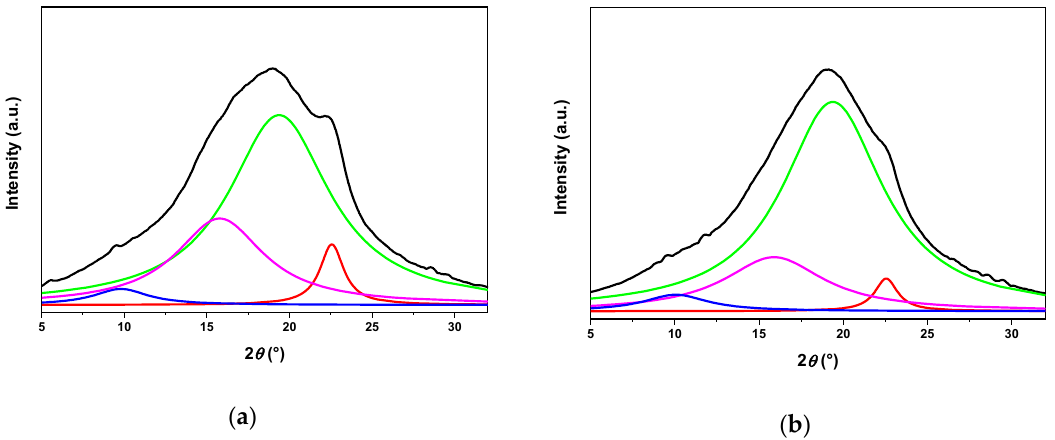
Figure 4. X-ray diffraction analysis of SEBS ( a ) and SEBS-g-IA ( b ), including their curve-fit. The experimental curve is the black line, while the blue, green, red and fuchsia lines correspond to the fitting curves. Table 2. XRD data of SEBS and SEBS-g-IA.